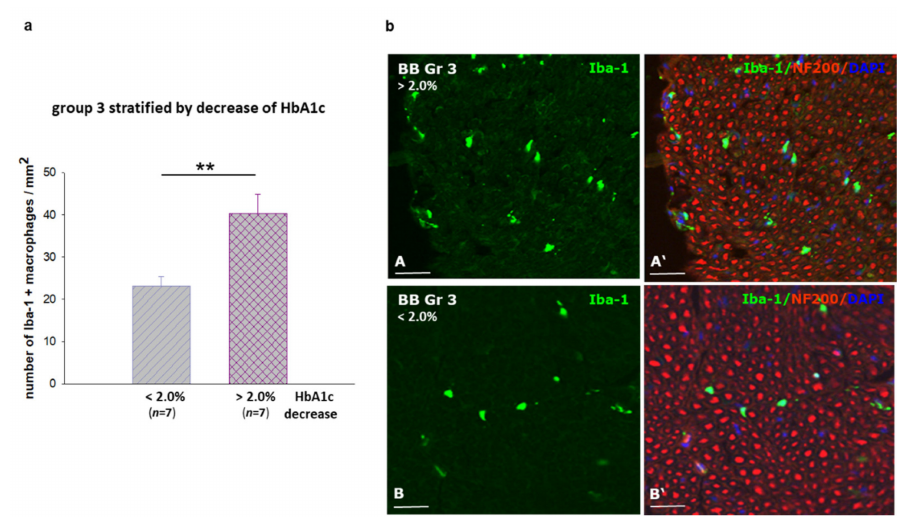
Figure 6. Macrophage distribution in sciatic nerves of BB/OKL rats in group 3 stratified by the reduction in HbA1c values at the end of month 3. ( a ) Quantification of Iba-1 (ionized calcium binding adaptor molecule 1)—positive macrophages. Data from n = 7 are presented as mean ± SEM. ** p ≤ 0.01 according to the one-way analysis of variance together with the Newman– Keuls test. ( b ) Representative photomicrograph of double IF staining for Iba-1 (green, macrophages) and for neurofilament 200 (red). Note that the greater number of macrophages in sciatic nerve correlated with a larger reduction of HbA1c values >2% as compared to the lesser reduction in HbA1c values <2%. Nuclei are stained with DAPI (4 (cid:48) ,6-diamidino-2-phenylindol, blue). Bars represent 50 µ m (AB–A’B’).